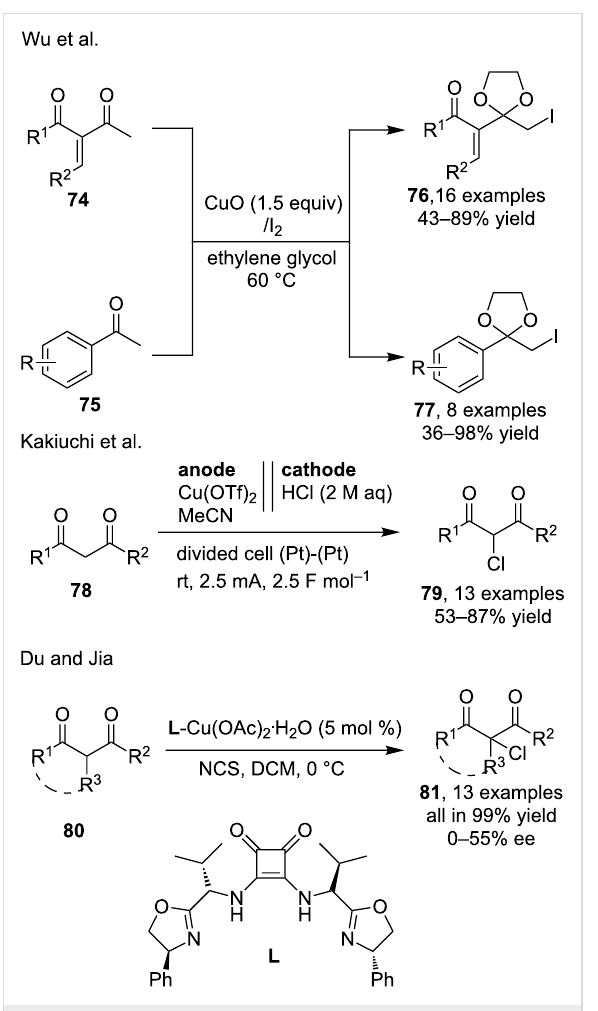
Scheme 25: Copper-catalyzed or mediated C–H halogenations of active C(sp 3